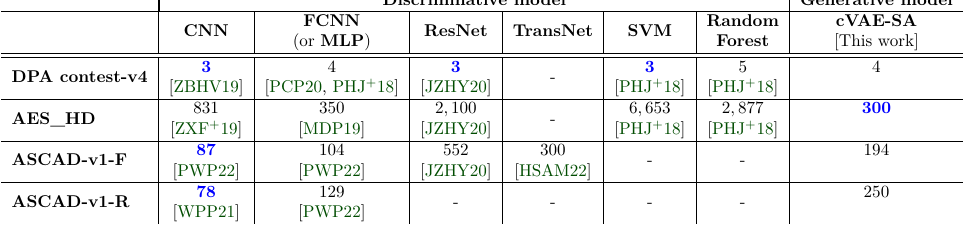
Table 4: DLSCA benchmark of ¯ Nt rank value depending on datasets. The best performance for each dataset is denoted in